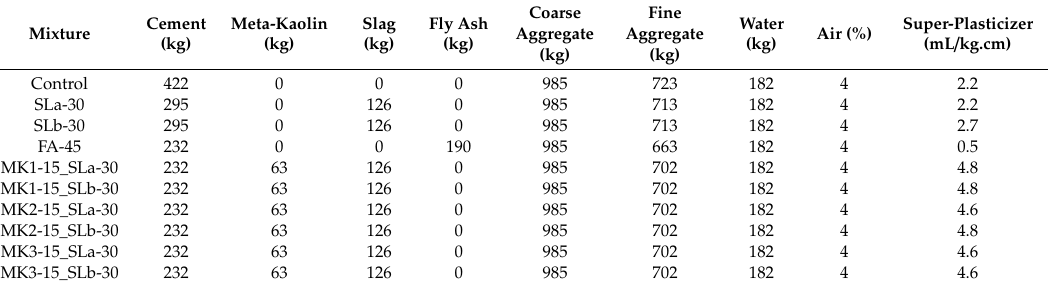
Table 2. Saturated surface-dry (SSD) proportions per m 3 of